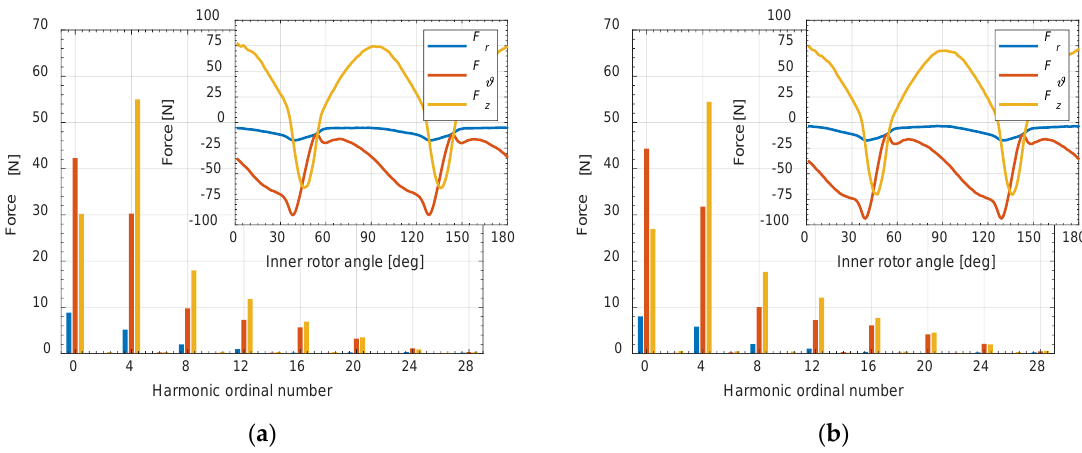
Figure 8. Force components acting on a selected SMC modulator core and their FFT spectra at max. load for two gear variants: ( a ) MG 1 ( b ) MG 2.